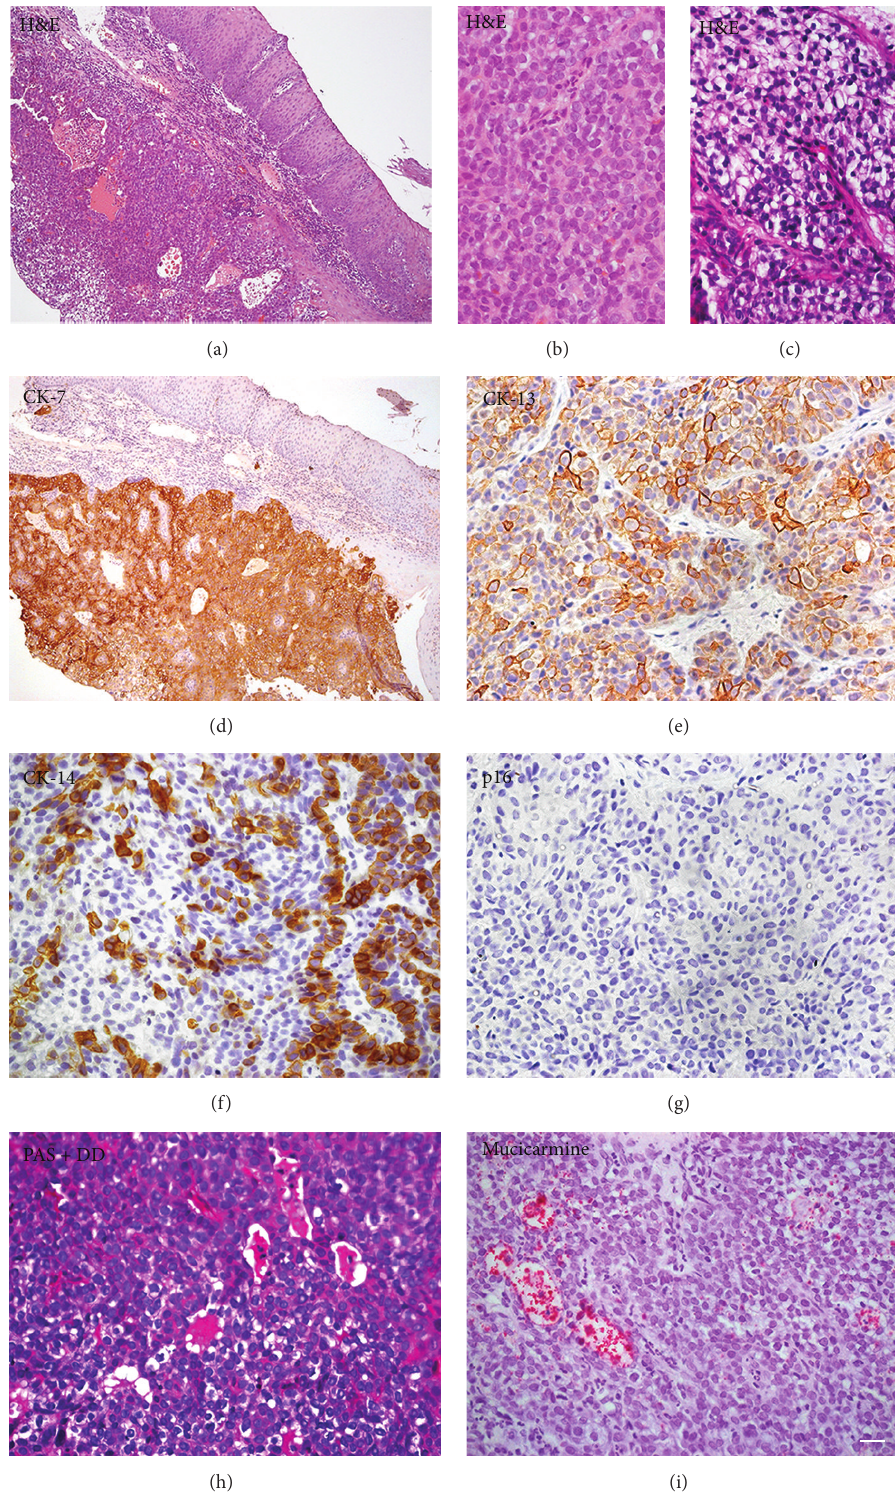
Figure 2: (a) H&E revealing a neoplasm of glandular epithelial origin within the lamina propria. (b) The cells showed a homogenous morphology with few cells showing atypia and mitotic figures. (c) Clear cells were observed in some areas. The neoplastic cells were positive for (d) CK-7, (e) CK-13, and (f) CK-14 and negative for (g) p16. (h) PAS with diastase digestion (i) and mucicarmine were also detected within the tumor. Scale bar: (a, c) = 80 𝜇 m; (b, d, e, f, g, h) = 20 𝜇